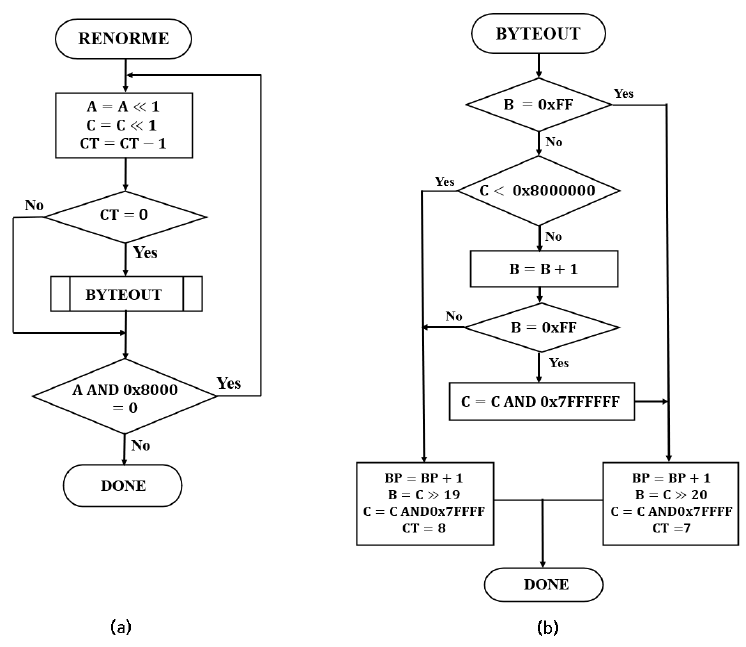
Figure 3. ( a ) RENORME procedure, ( b ) BYTEOUT procedure.